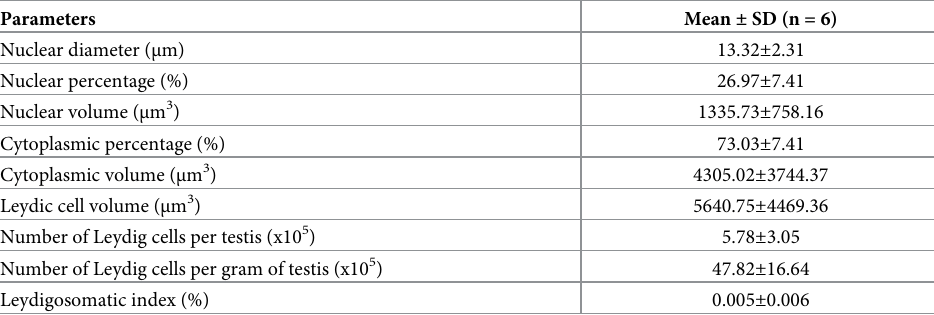
Table 3. Morphometry of the Leydig cell of Diphylla ecaudata . The data are reported as mean ± standard deviation (SD) of the